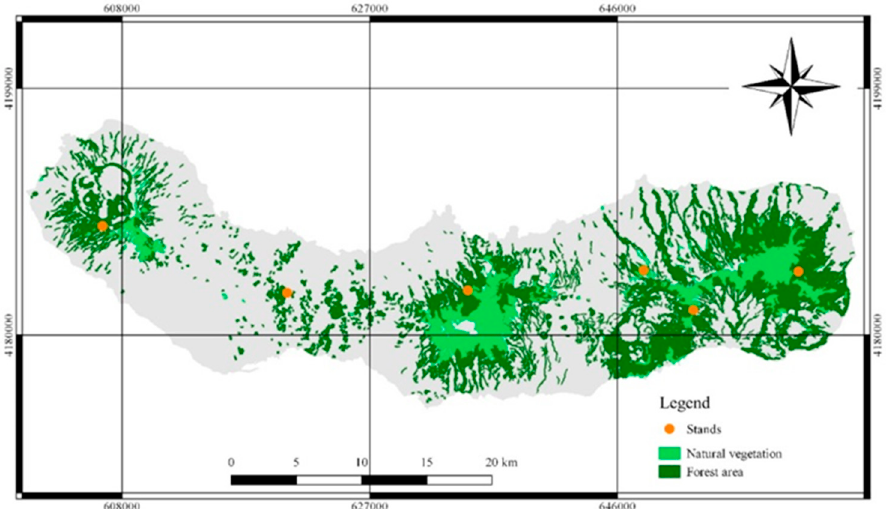
Figure 1. Distribution of the six selected stands of natural vegetation in São Miguel Island. From left to right: Sete Cidades; Pinhal da Paz; Lombadas; Achada das Furnas; Povoação; Tronqueira. In the map, natural vegetation is not entirely forest.